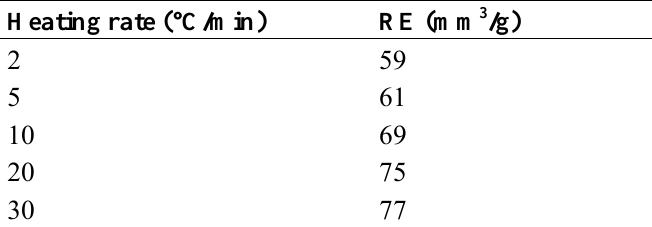
Table 2. Expansion ratio at different compression